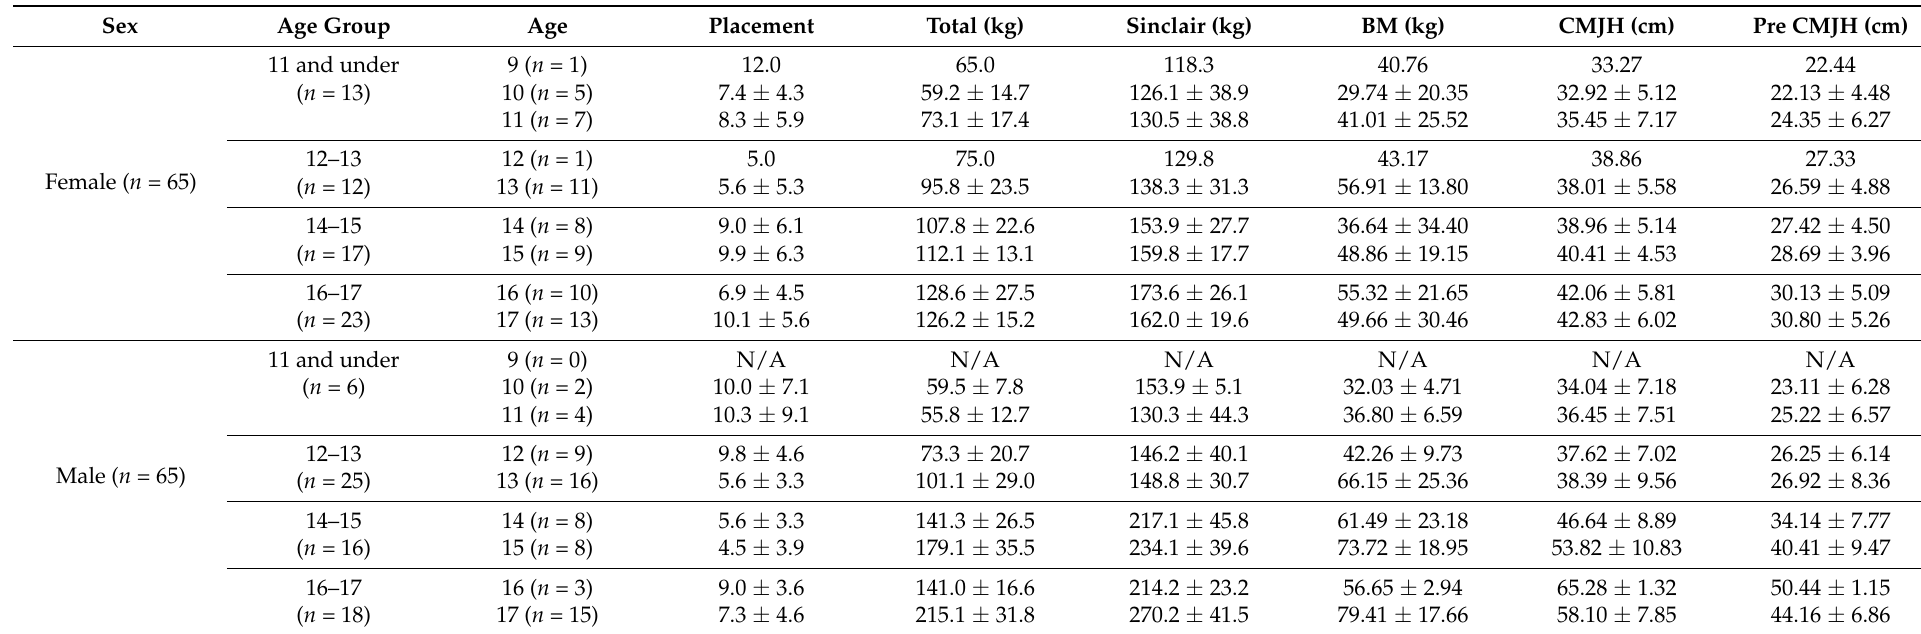
Table 1. Characteristics of participating youth